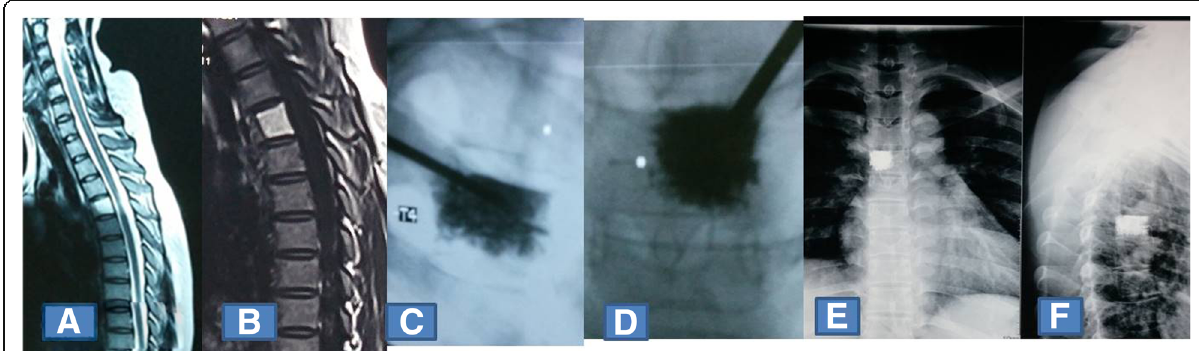
Fig. 1 A 25-year-old female with complaints of upper thoracic back pain with tenderness localized to T4. a , b MRI T1 and T2WI thoracolumbar spine shows a hyperintense lesion on both T1 and T2 s/o vertebral hemangioma in D4 vertebral body. c , d DSA image AP and lateral view showing unipedicular injection of cement. e , f Post-vertebroplasty X-ray image of thoracic spine shows adequate filling of bone cement in the body of D4 vertebra with no extension in to IV disc space. On follow-up, patient had significant relief in pain with decrease in morbidity and no tenderness at D4 level